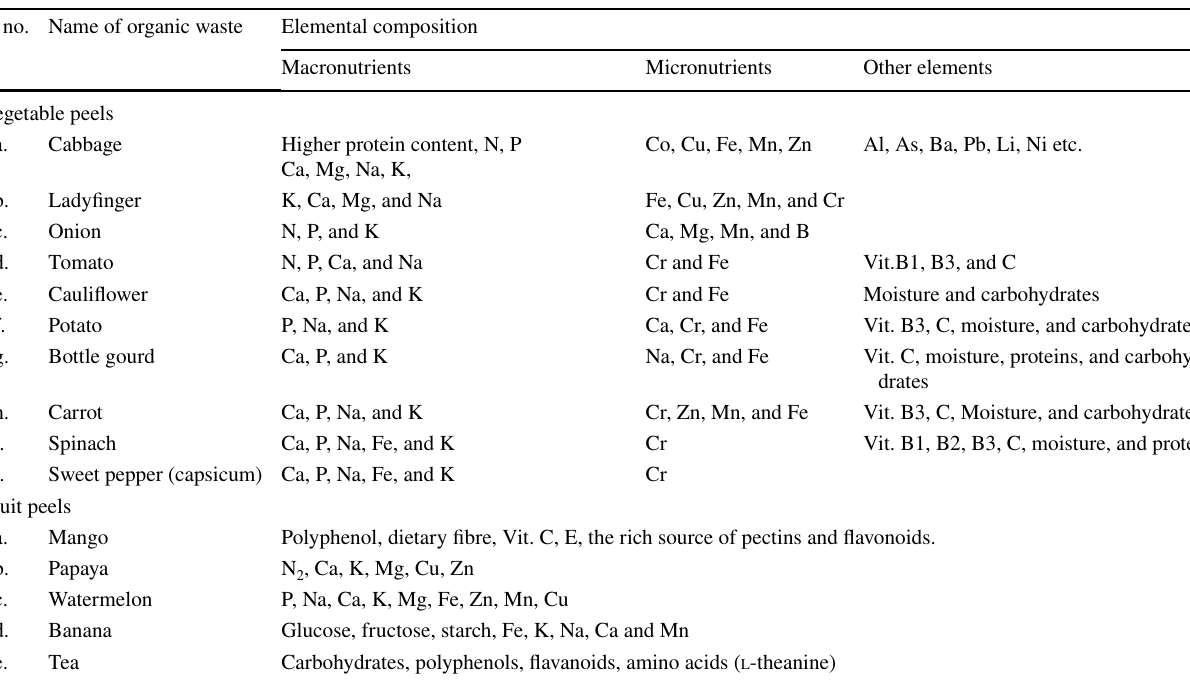
Table 1 Elemental composition of different organic waste procured from kitchen S. no. Name of organic